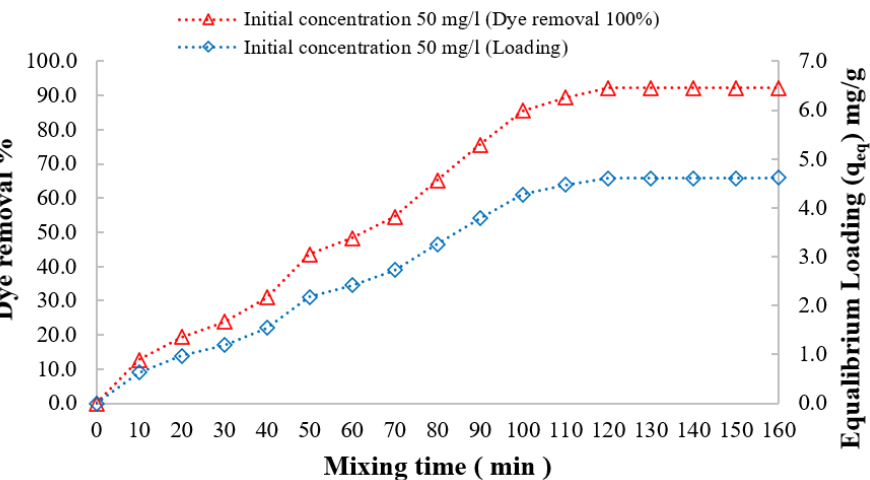
Figure 16. Effect of mixing time on DB78 dye removal efficiency. Adsorbent, CCMB-0.25:1; temper- ature of 22 °C; pH of 3; and mixing speed of 150 r.p.m.